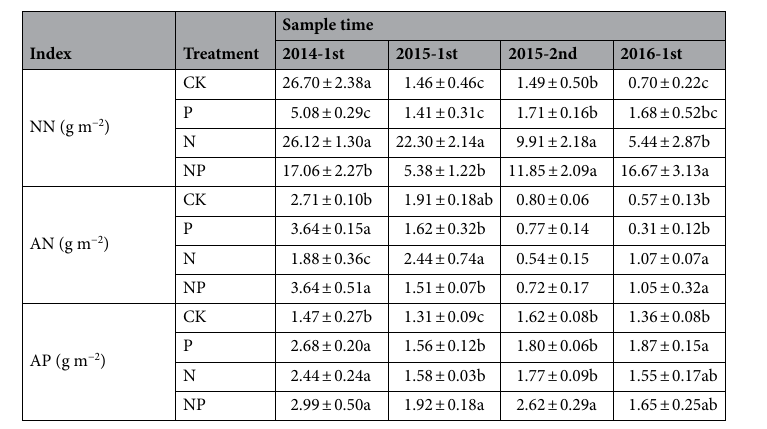
Table 3. Characteristics of soil nitrate nitrogen (NN), ammonium nitrogen (AN) and available phosphorus (AP) contents under N and P